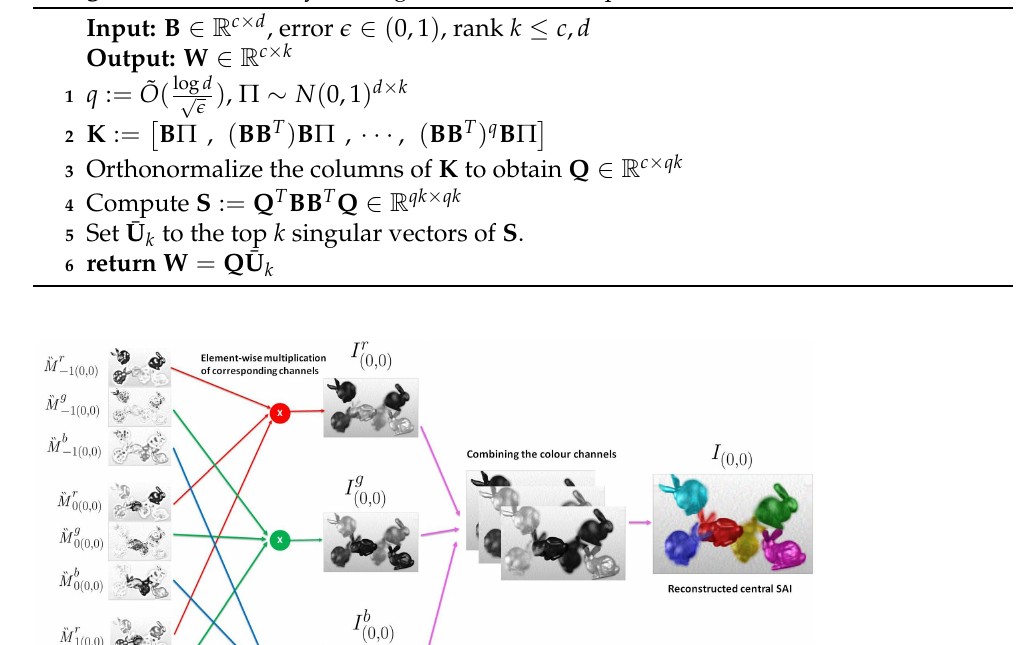
Algorithm 2: Block Krylov Singular Value Decomposition